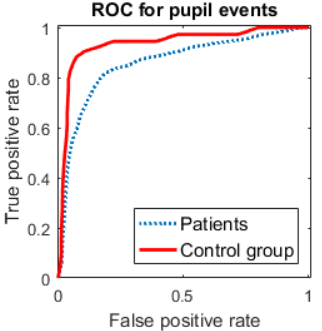
Fig.6. Receiver operating curves of the classification per- formance for both the visual field defect patients and the control